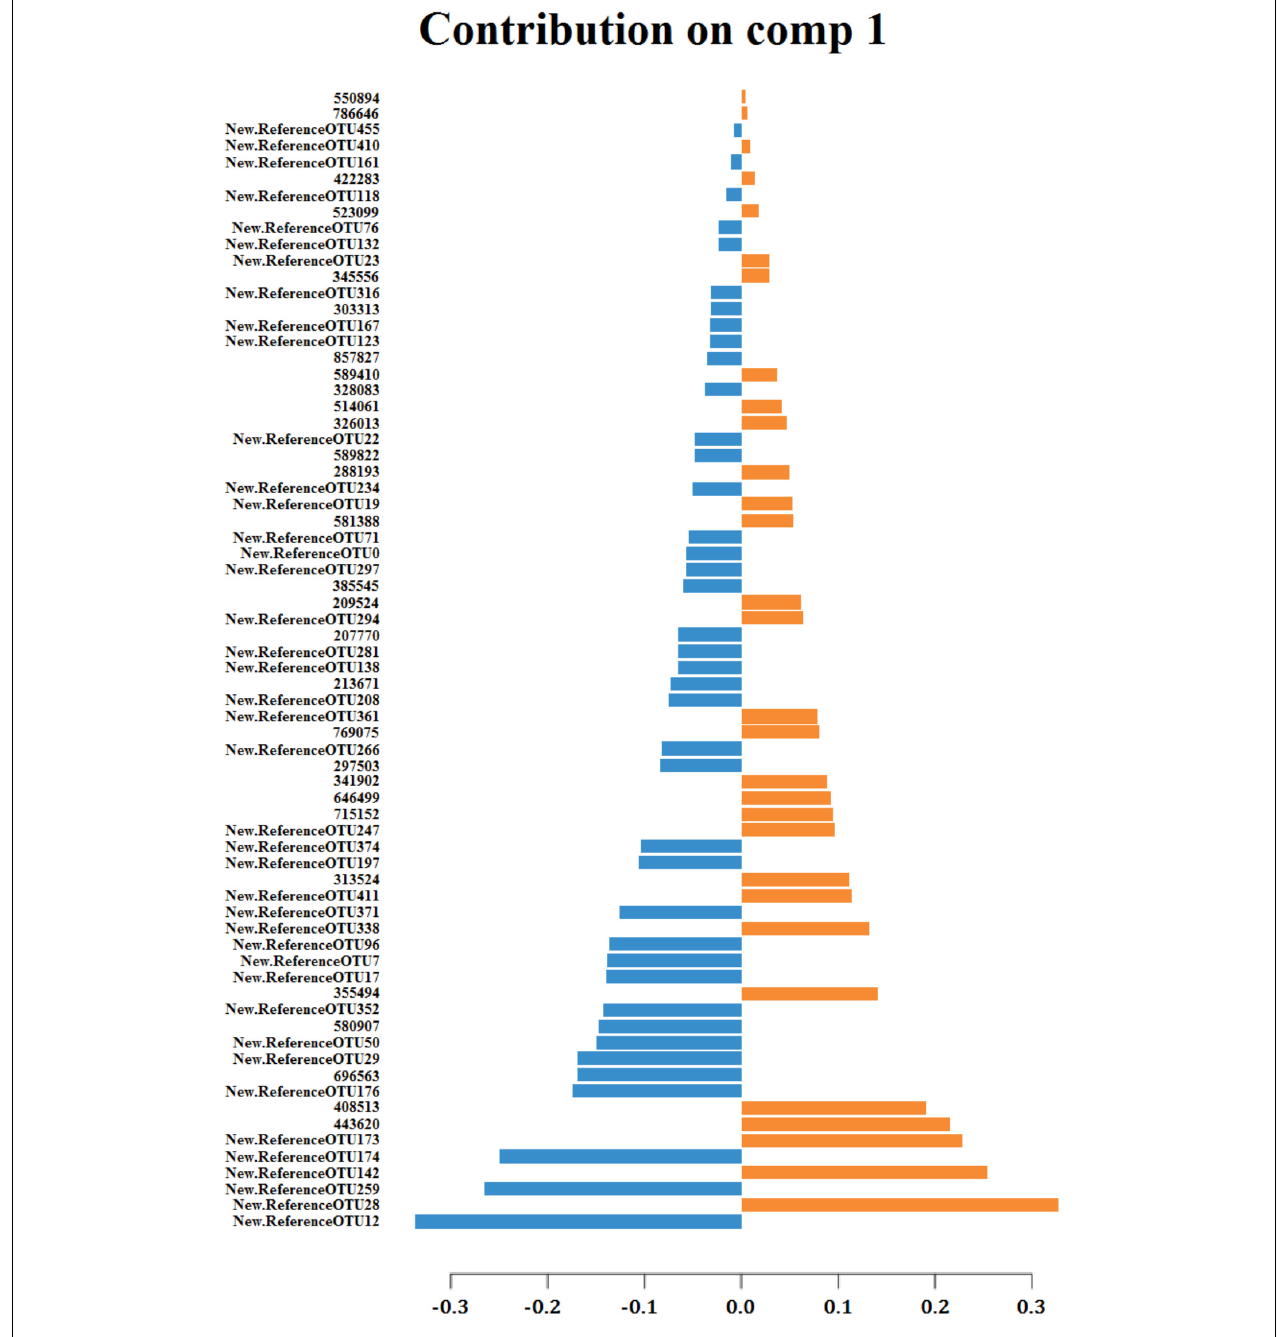
FIGURE 4 | Contribution of each OTU, on component 1 of sPLS-DA, to the discrimination of samples regarding to their sampling origin: cecum (blue) or feces